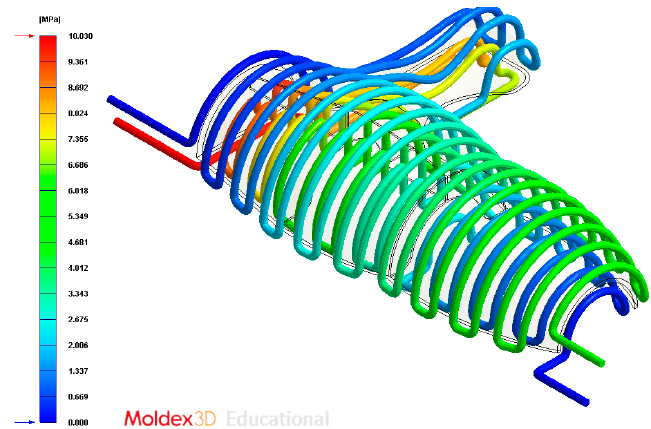
Figure 23. Pressure (MPa) of the coolant along the cooling system, Case B.